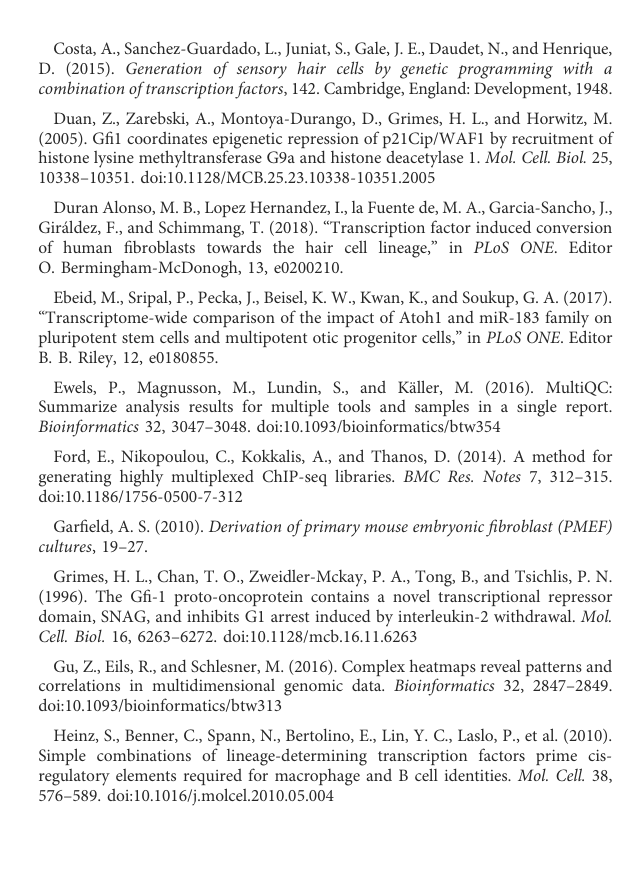
motifs are detected in the iGPA-unique peaks. G fi 1 motifs are not detected at all.